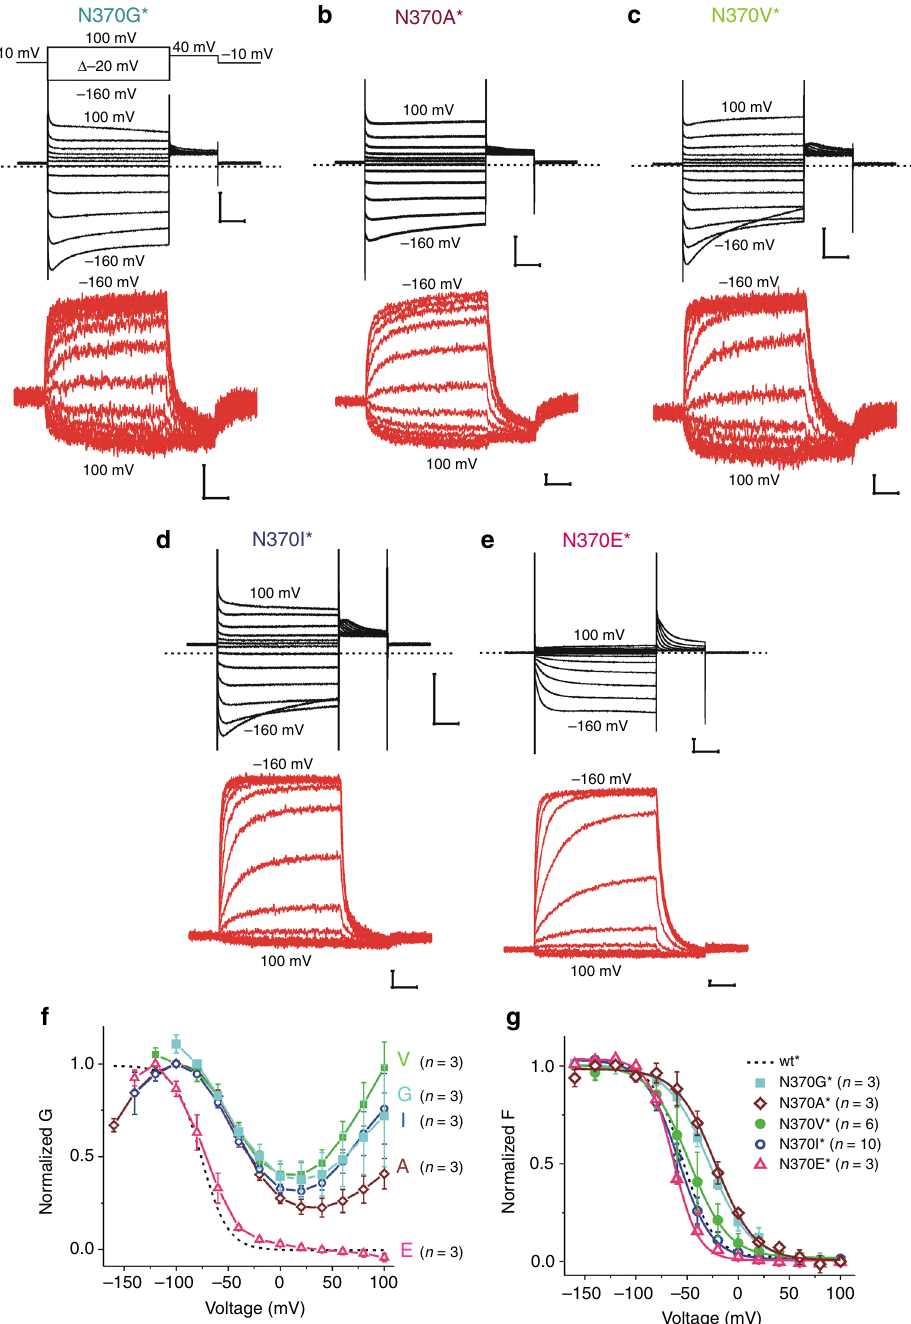
Fig. 3 Hydrophobic N370 mutants have wt-like S4 movement but do not close completely. Representative current (black) and fl uorescence (red) from